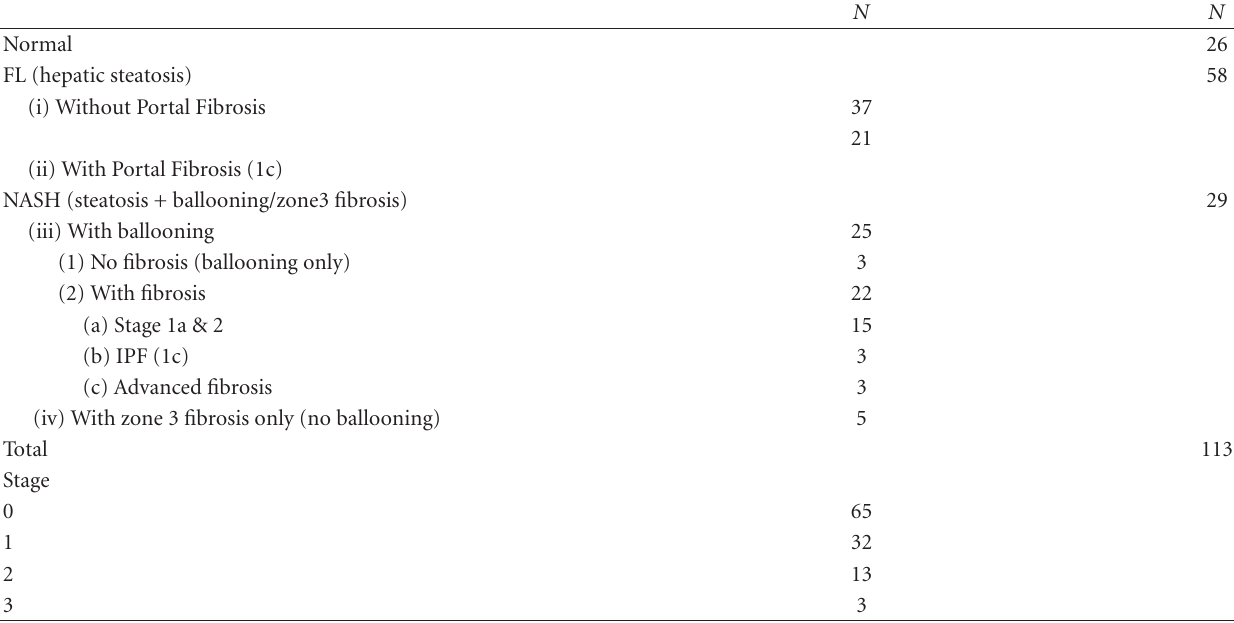
Table 2: Histological classification of study population for the spectrum of